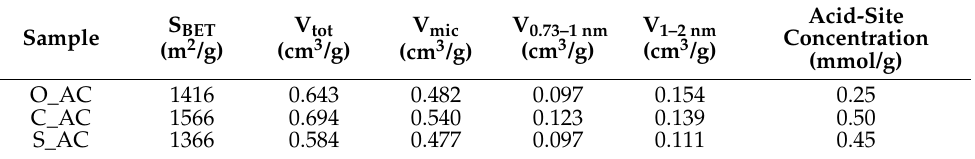
Table 2. Surface properties of tested activated